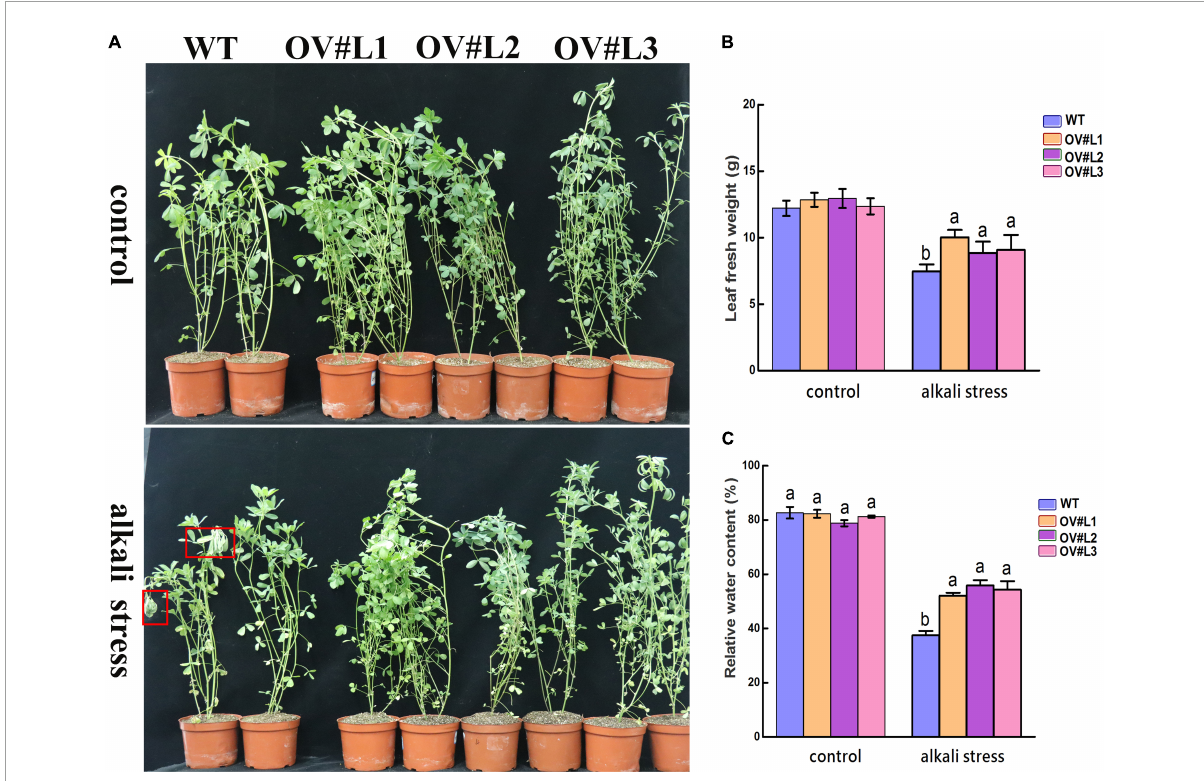
FIGURE3 Alkali stress tolerance analysis of MsNF-YC2 overexpression lines and WT plants. (A) Phenotypic analysis of MsNFYC2 overexpression plants under 5-day alkali stress treatment. (B) Relative fresh weight. (C) Relative root length. Significant differences by different letters above the bars at the P < 0 . 05 level according to Duncan’s multiple range